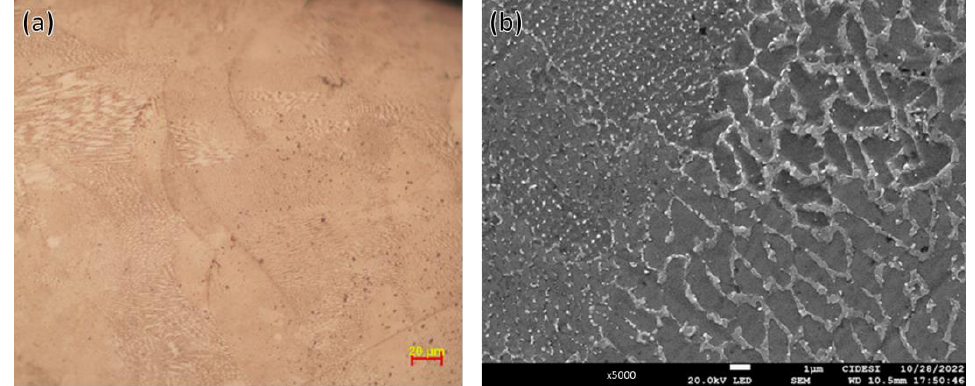
Figure 3. Microstructure of cellular IN718 in the “as - built” condition. ( a ) Optical microscopy at 500×. ( b ) SEM image at 5000×. ( b ) SEM image at 5000 ×